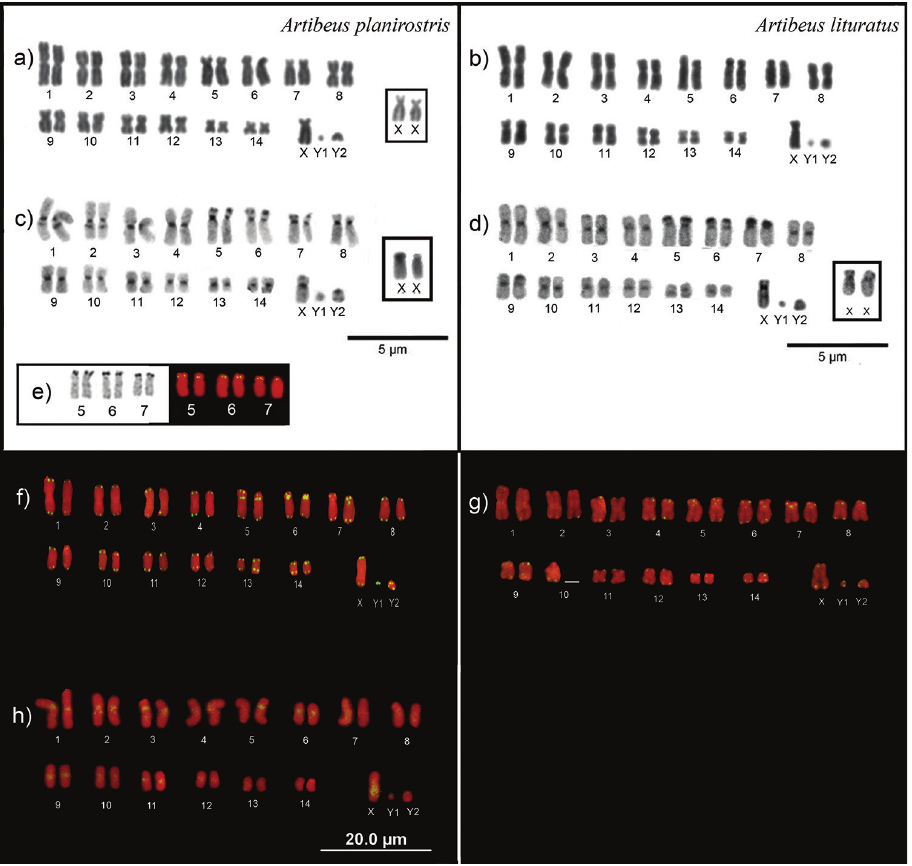
Figure 1. Karyotypes of A. planirostris ( a, c, e, f, h ) and A. lituratus ( b, d, g ). Conventional staining ( a, b ); C-banding patterns ( c, d ); Ag-NOR staining (left) and FISH with rDNA 18S (rigth; e ), FISH using telo- meric repeats as probes ( f, g ), FISH with probes from the open reading frame (ORF) II of LINE-1 from A. planirostris ( h